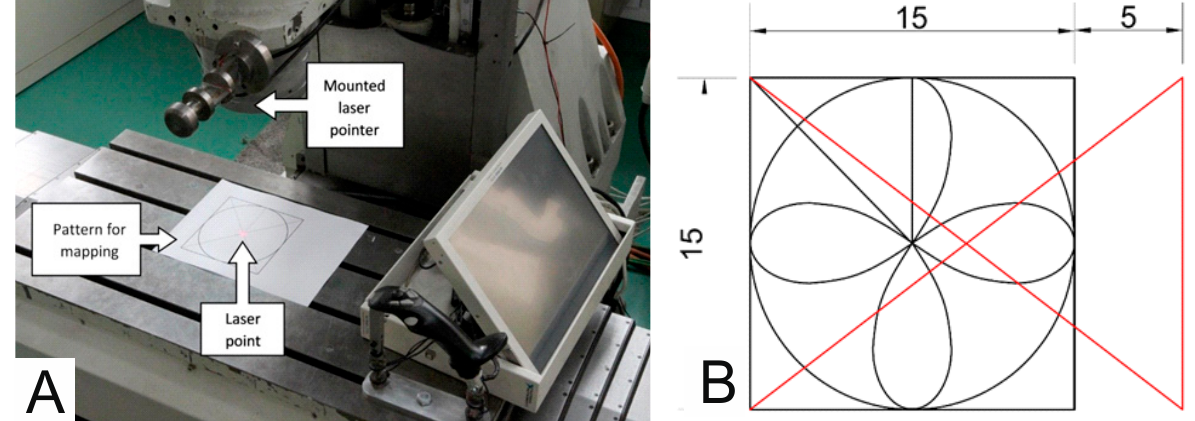
Figure 7. ( A ) Test stand configuration, ( B ) pattern used to calibrate the system.